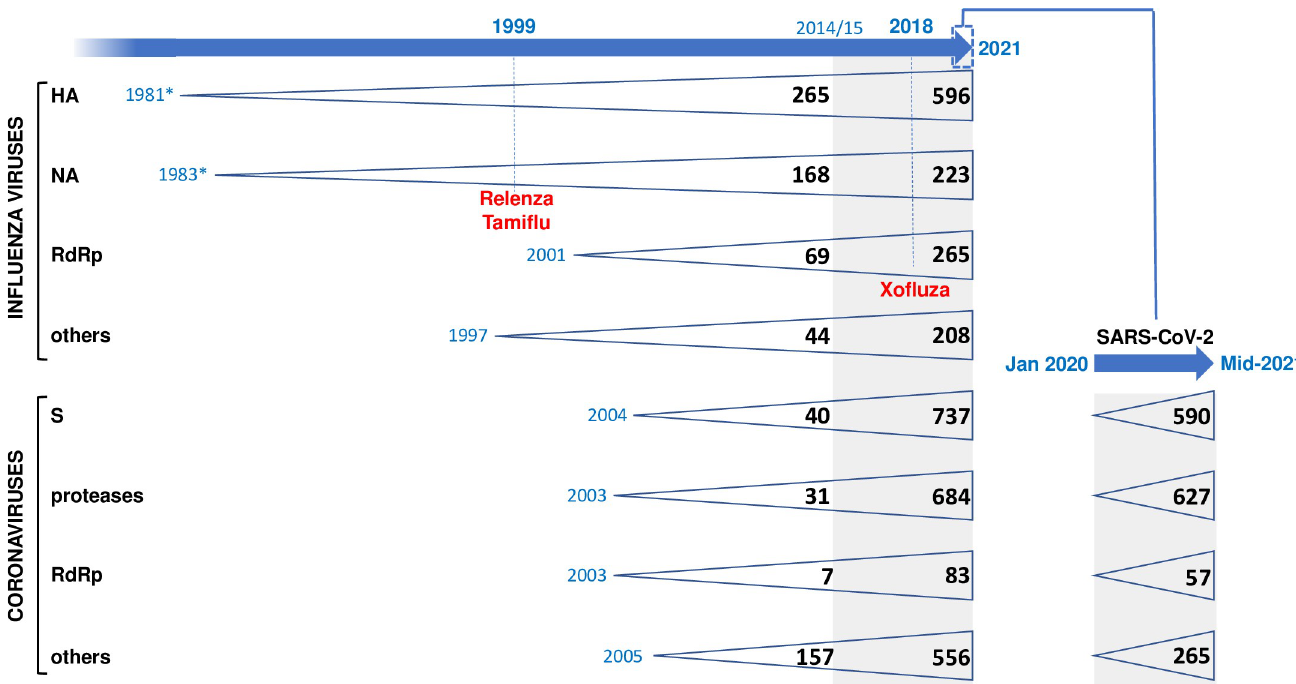
Fig 2. Growing pool of structural data available for influenza viruses and coronaviruses. The number of 3D structures available in the Protein Data Bank (https://www.rcsb.org, 17 October 2021) for each of the indicated category of viral proteins has been recorded separately for the 1981 to 2014 and the 2015 to 2021 period (the latter corresponding to an extended use of new generation detectors and cryo-EM, gray background). SARS-CoV-2 protein structures were counted separately (inset on the right). The years when the Relenza, Tamiflu and Xofluza inhibitors were approved by the FDA are indicated. RdRp, RNA-dependent RNA polymerase: PB1, PB2, and PA proteins of influenza viruses; nsp7, nsp8, nsp10, nsp12, and nsp14 proteins of corona viruses. Proteases: nsp3 and nsp5. � corresponds to the publication years of the first HA and NA X-ray structure, which preceded by several years their deposition in the PDB. HA, hemagglutinin; NA, neuraminidase; S, Spike; SARS-CoV-2, Severe Acute Respiratory Syndrome Coronavirus 2.